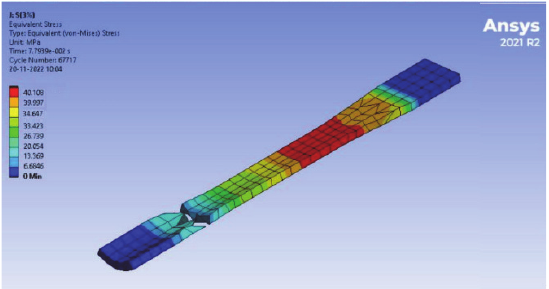
Figure 11: Maximum equivalent stress in the S3 tensile specimen.